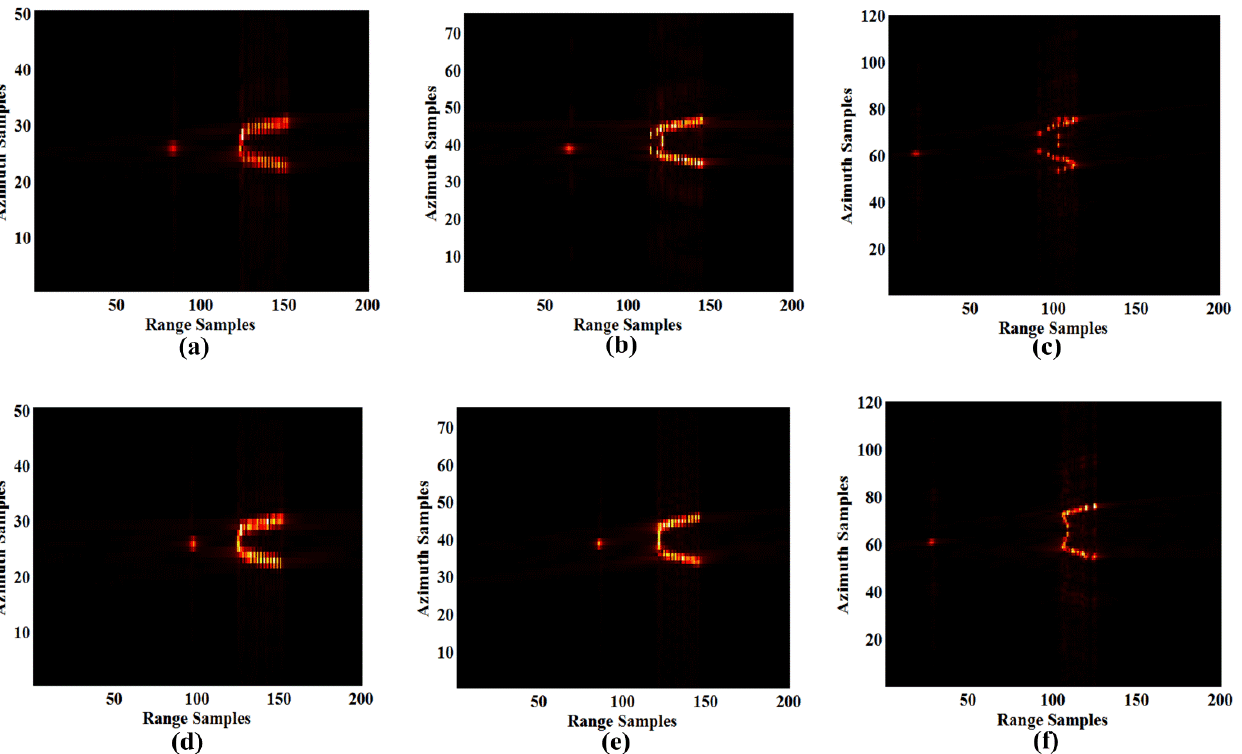
Figure 22. ISAR image of the hypersonic target in scenes 4 and 5 using X-band, Ku-band, and Ka-band radar. ( a ) X-band in scene 4. ( b ) Ku-band in scene 4. ( c ) Ka-band in scene 4. ( d ) X-band in scene 5. ( e ) Ku-band in scene 5. ( f ) Ka-band in scene 5. When a hypersonic target has an attack angle, two ISAR image variations occur at distinct radar frequencies, which is shown in Figure 23. The stagnation point for X-band and Ku-band is to the left of other scattering points. For Ka-band, the middle and tail scattering points shift to the left and surround the stagnation point. At this time, the distortion of the ISAR image is more severe.